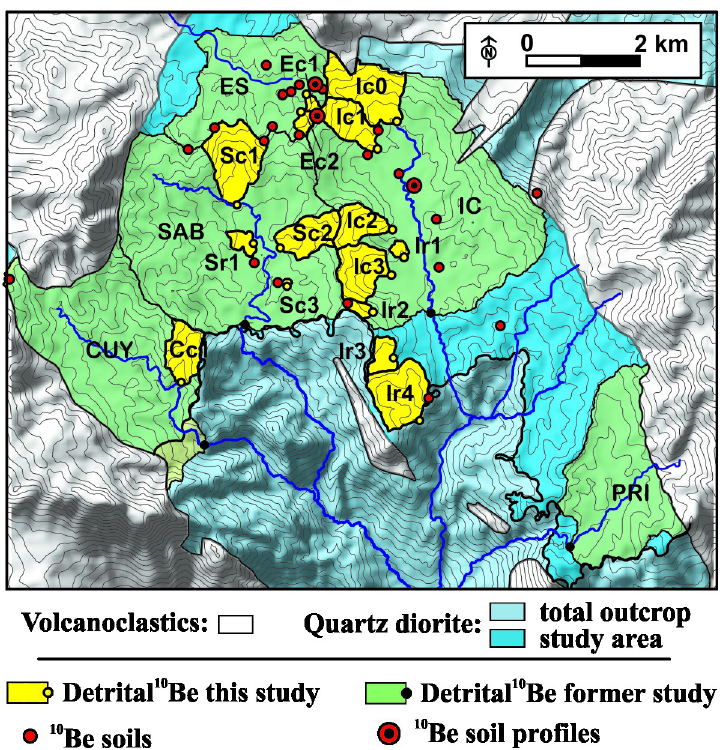
Fig 2. Sampling locations chosen for 10 Be measurements in soils and river sediments. The map shows the extent of the watershed feeding river borne quartz used for 10 Be detrital rates measurements, in this study and earlier studies [9, 12]. Grey lines: contour lines with 25 m elevation spacing (10 m-resolution DEM). Large catchment names: CUY: Cubuy, ES: Espiritu´ Santo, IC: Icacos, PRI: Prieto, SAB: